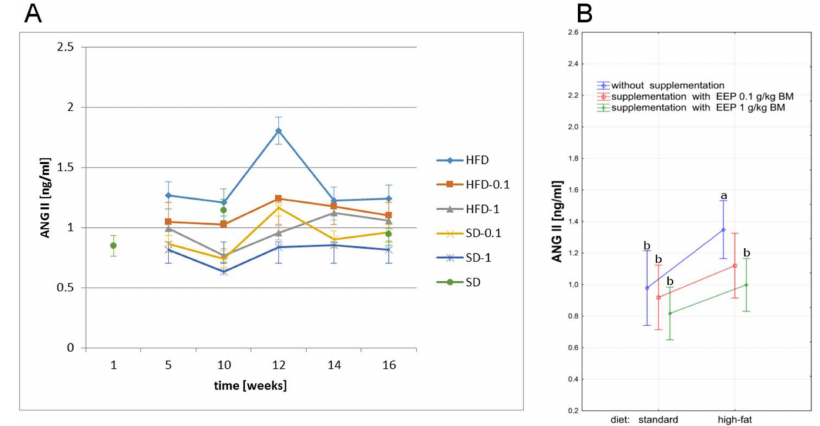
Figure 7. Angiotensin II level in C 57 BL 6 mice. ( A ) ANG II level in particular weeks of the